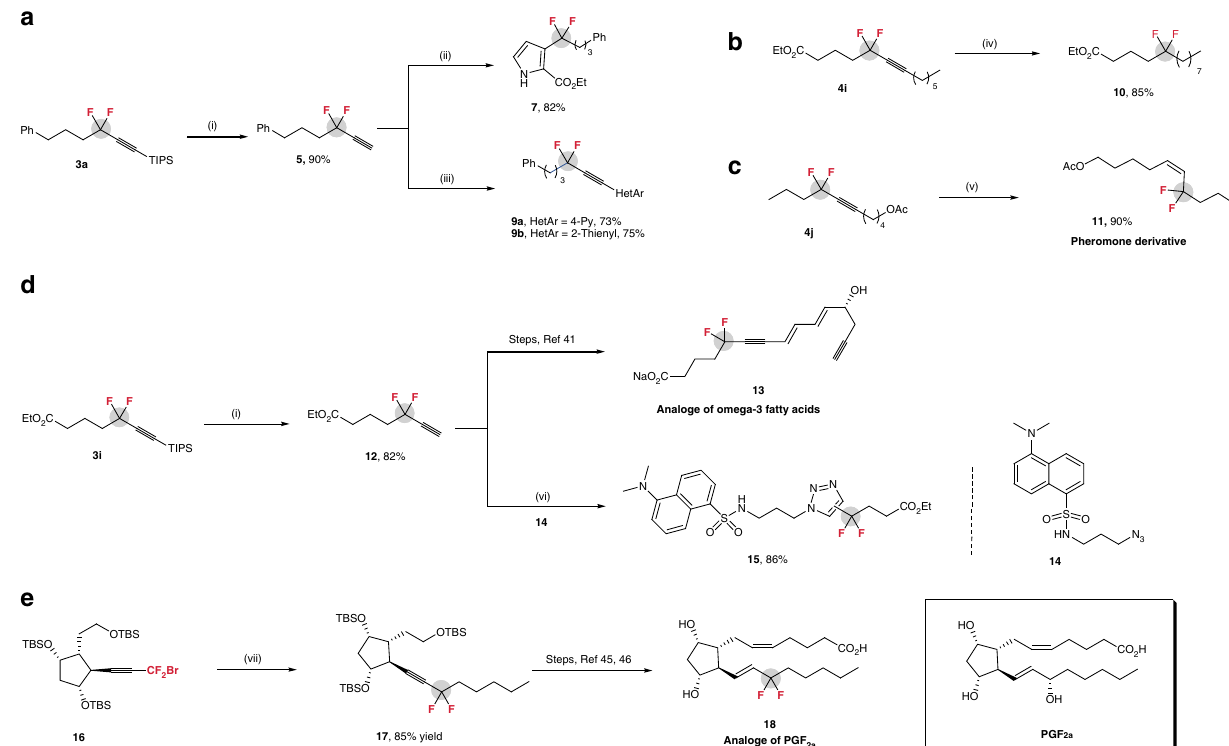
Fig. 1 Transformations of compounds 3 and 4 . a Transformation of 3a . Conditions: (i) TBAF, THF, − 78 o C to − 20 o C; (ii) Ag 2 CO 3 (10 mol%), EtO 2 CCH 2 NC 6 , dioxane, 80 o C; (iii) Pd(PPh 3 )Cl 2 (5 mol%), CuI (5 mol%), HetArI 8 , i Pr 2 NH. b Transformation of 4i . Conditions: (iv) Pd/C (10%), H 2 (1 atm). c Synthesis of pheromone derivative 11 . Conditions: (v) Lindlar catalyst, H 2 (1 atm). d Transformation of 3i . Conditions: (vi) PBS (PH 7.4), 37 o C. e Synthesis of key intermediate 17 of biologically active molecule PGF 2a derivative. Conditions: (vii) Ni(dppf)Cl 2 (5 mol%), tpy (5 mol%), n -Pentylzinc bromide, dioxane/ DMA, 40 o C, 12 h